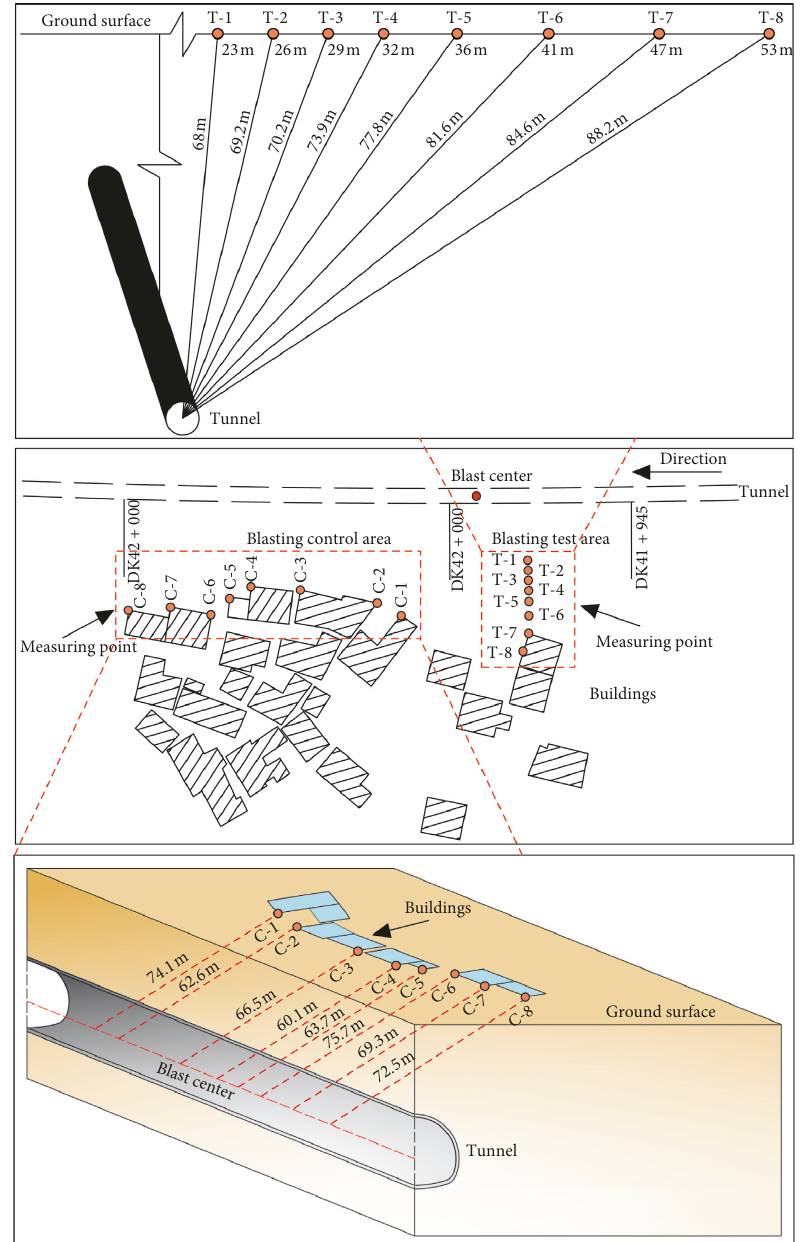
Figure 4: Layout of the vibration monitoring